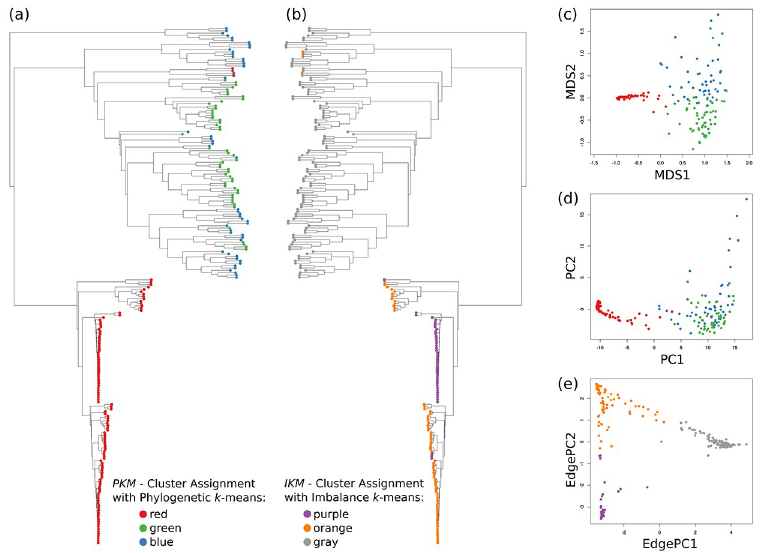
Fig 8. Comparison of k -means clustering to Squash Clustering and Edge PCA. We applied our variants of the k - means clustering method to the Bacterial Vaginosis (BV) dataset in order to compare them to existing methods. See [18] for details of the dataset and its interpretation. We chose k ≔ 3, as this best fits the features of the dataset. For each sample, we obtained two cluster assignments: First, by using Phylogenetic k -means, we obtained a cluster assignment, which we here abbreviate as PKM . Second, by using Imbalance k -means, we obtained an assignment here abbreviated as IKM . In each subfigure, the 220 samples are represented by colored circles: red, green, and blue show the cluster assignments PKM , while purple, orange, and gray show the cluster assignments IKM . (a) Hierarchical cluster tree of the samples, using Squash Clustering. The tree is a recalculation of Figure 1(A) of Srinivasan et al . [18]. Each leaf represents a sample; branch lengths are Kantorovich-Rubinstein (KR) distances between the samples. We added color coding for the samples, using PKM . The lower half of red samples are mostly healthy subjects, while the green and blue upper half are patients affected by Bacterial Vaginosis. (b) The same tree, but annotated by IKM . The tree is flipped horizontally for ease of comparison. The healthy subjects are split into two sub-classes, discriminated by the dominating species in their vaginal microbiome: orange and purple represent samples were Lactobacillus iners and Lactobacillus crispatus dominate the microbiome, respectively. The patients mostly affected by BV are clustered in gray. (c) Multidimensional scaling using the pairwise KR distance matrix of the samples, and colored by PKM . (d) Principal component analysis (PCA) applied to the distance matrix by interpreting it as a data matrix. This is a recalculation of Figure 4 of [101], but colored by PKM . (e) Edge PCA applied to the samples, which is a recalculation of Figure 3 of Matsen et al . [101], but colored by IKM